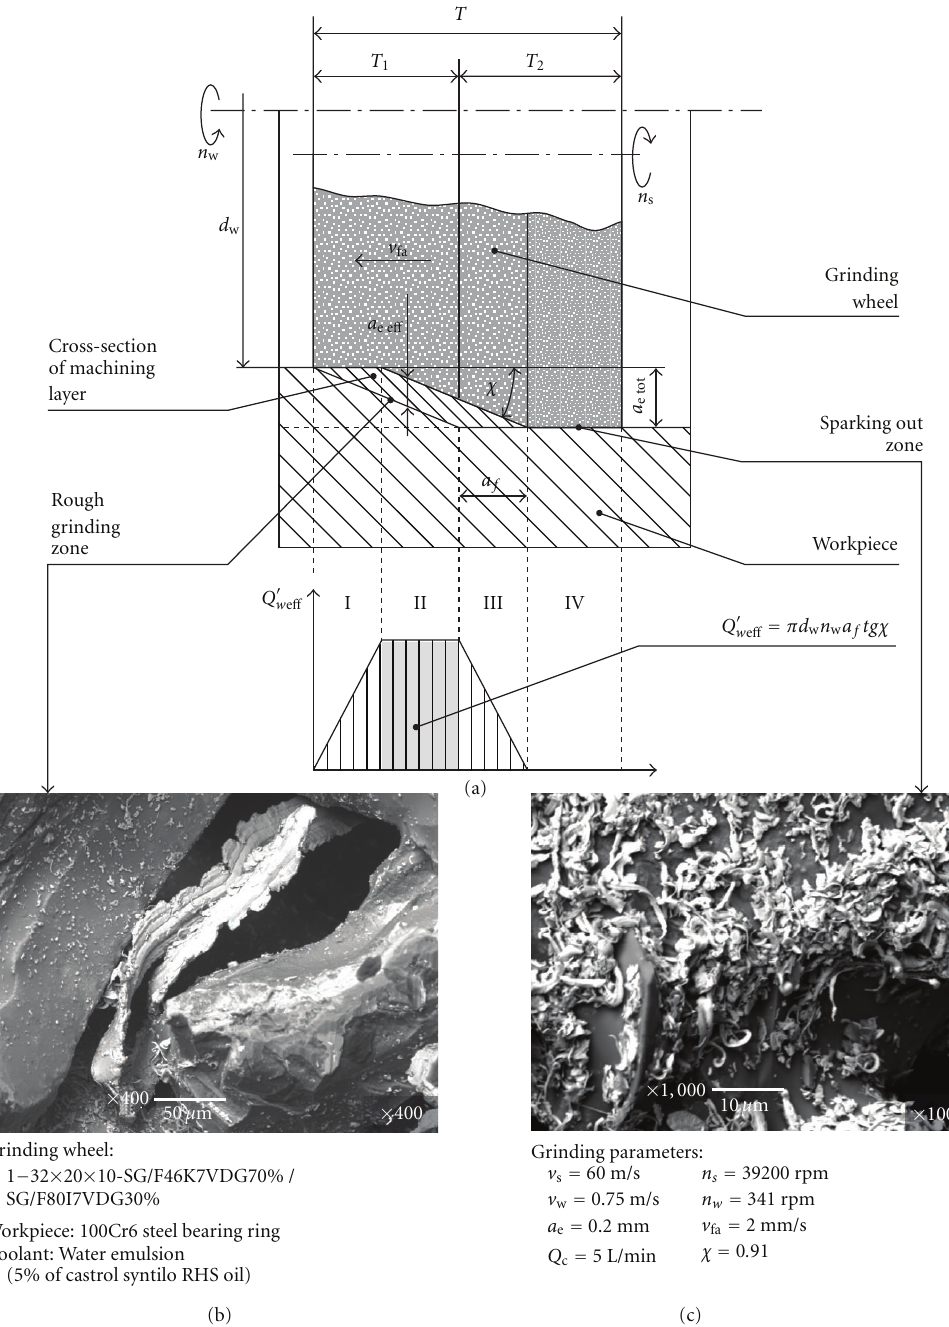
Figure 4: Grinding wheel active surface load in the single-pass internal cylindrical grinding process (a) and microscopic images of chips produced in the rough grinding zone (b) and finish grinding zone (c) of the zonediversified structure grinding wheel